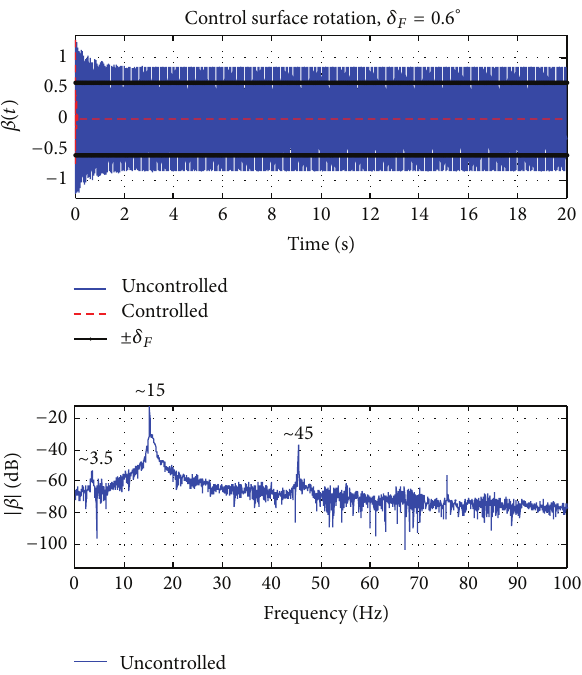
Figure 12: Case 1: control surface rotation ( |𝛿| = 0.6 ∘ and 𝑉 = 12.5